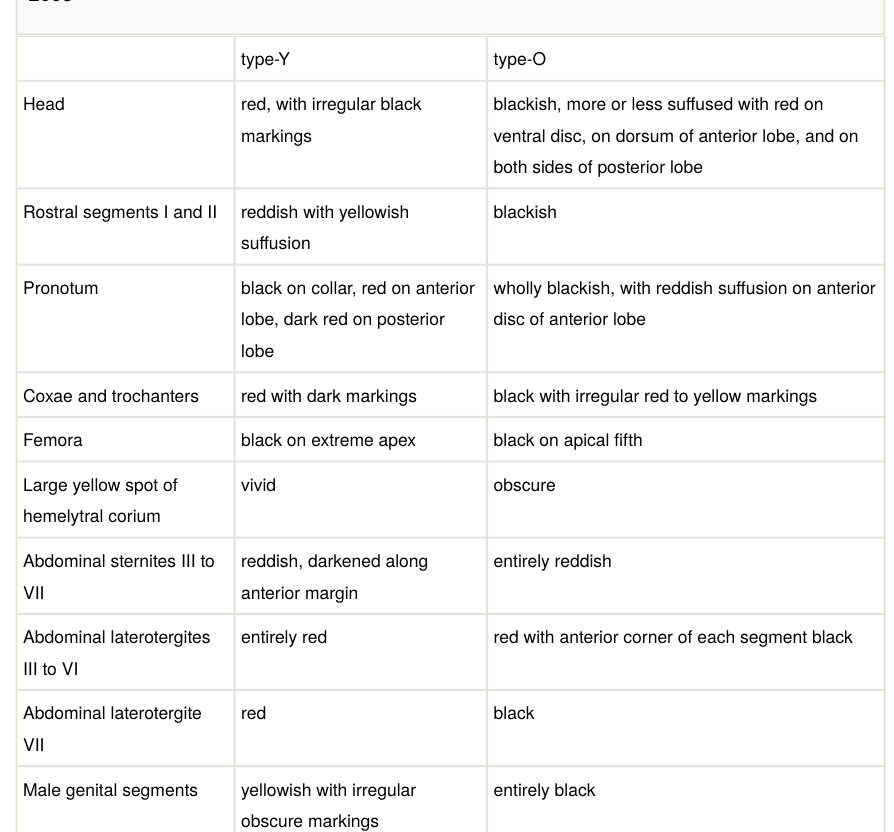
Discontinuous color variation in the assassin bug species Tiarodes miyamotoi